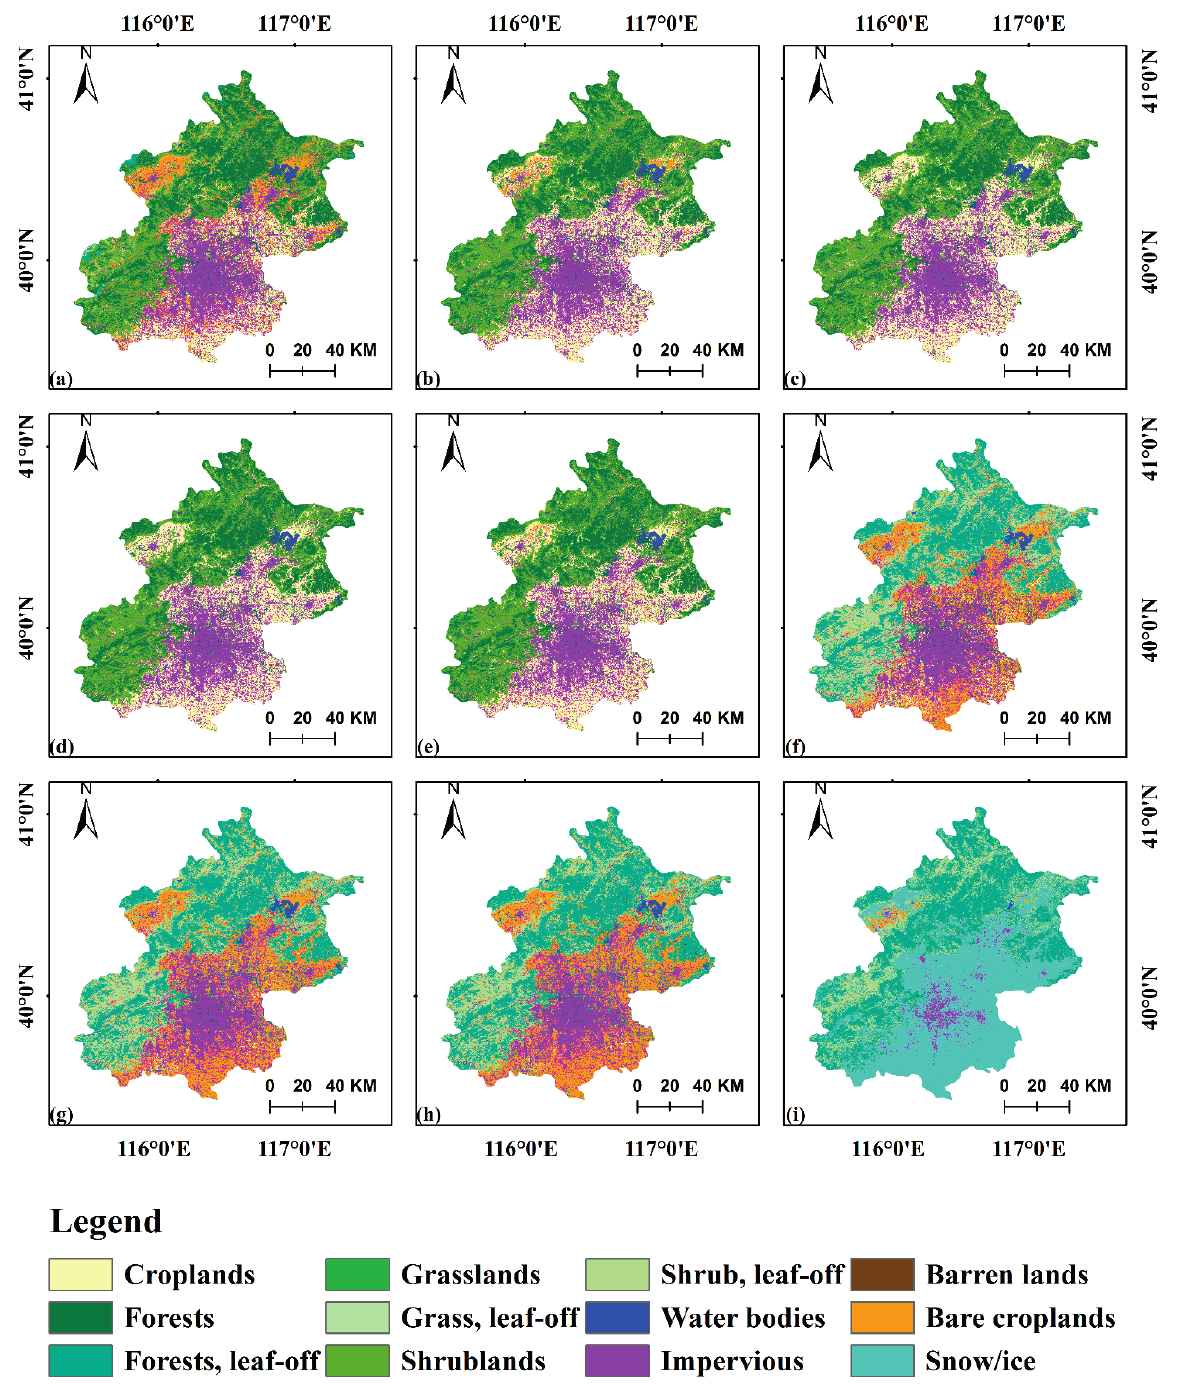
Figure 4. Land cover maps classified with all the 144 features. ( a – h ) are the maps for the eight dates (day of year (DOY) 132-356) in 2013. ( i ) is the map for DOY 39 in